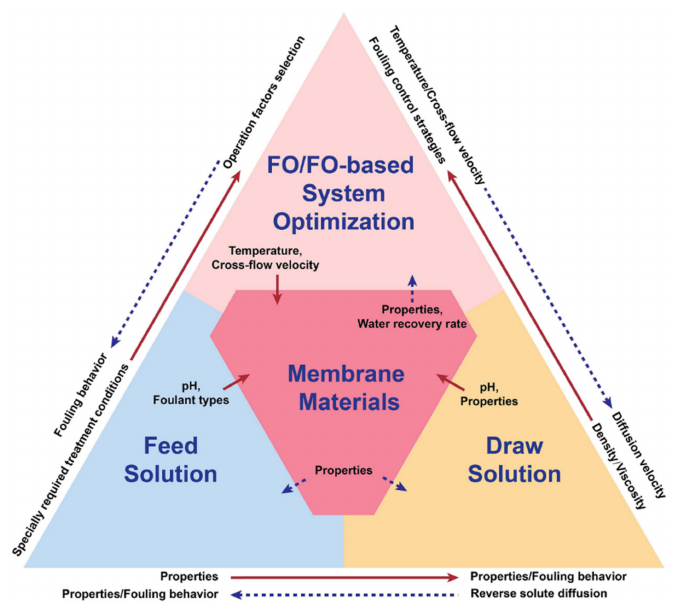
Figure 9. Schematic diagram of the relationships among membrane materials, draw solution, feed solution, and system optimisation in single FO or FO-integrated wastewater treatment